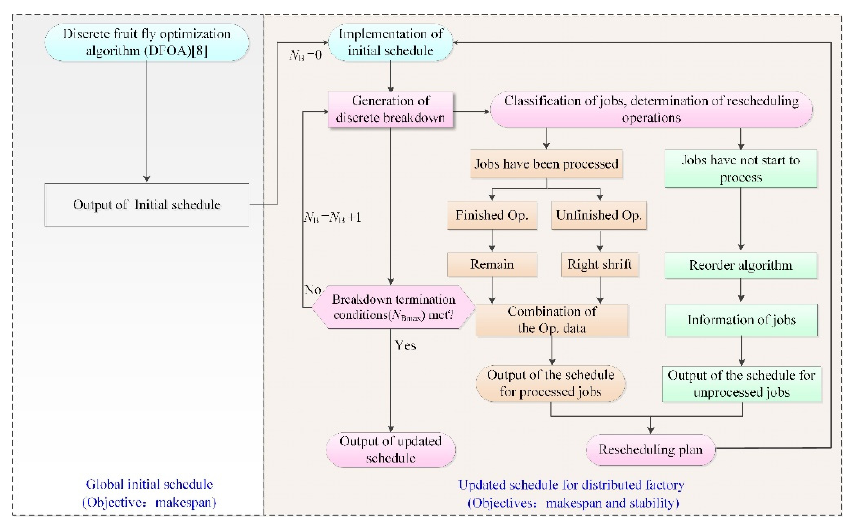
Figure 4. Proposed rescheduling procedure for DDBFSP.